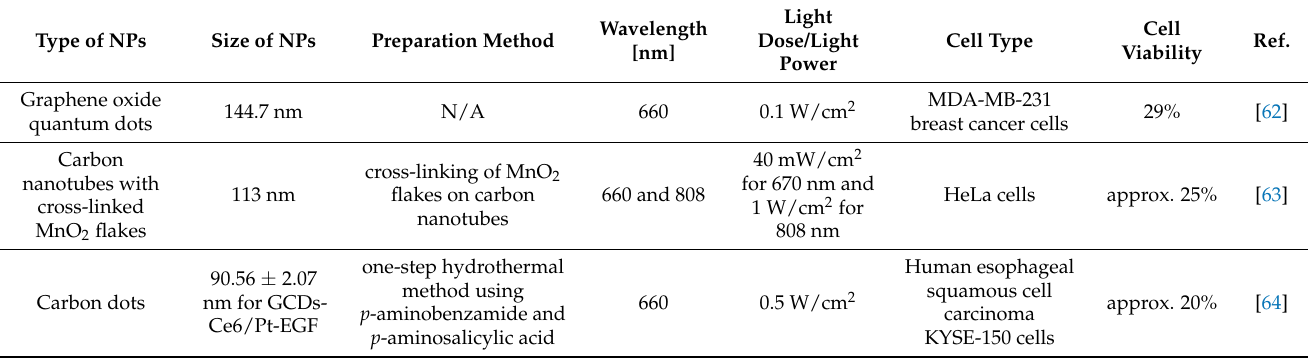
Table 5. Summary of the data presented in Section